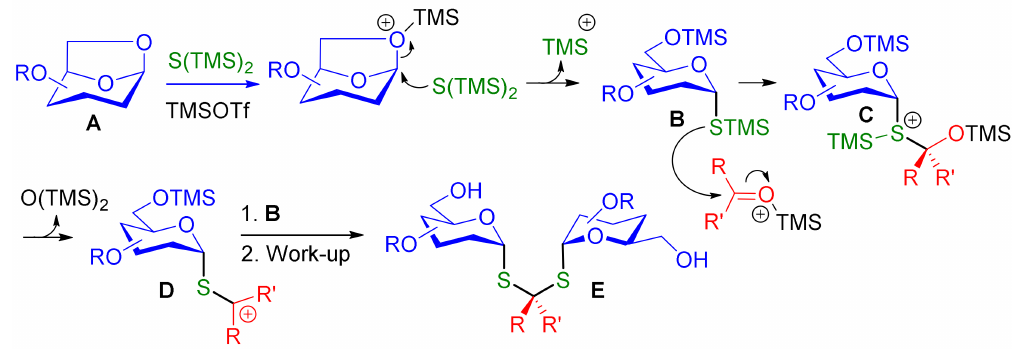
Figure 1. Tentative mechanism for the TMSOTf-mediated formation of dithioacetal diglycosides. According to Zhu’s optimized conditions [6], 1.4 equiv. of (TMS) 2 S were used in